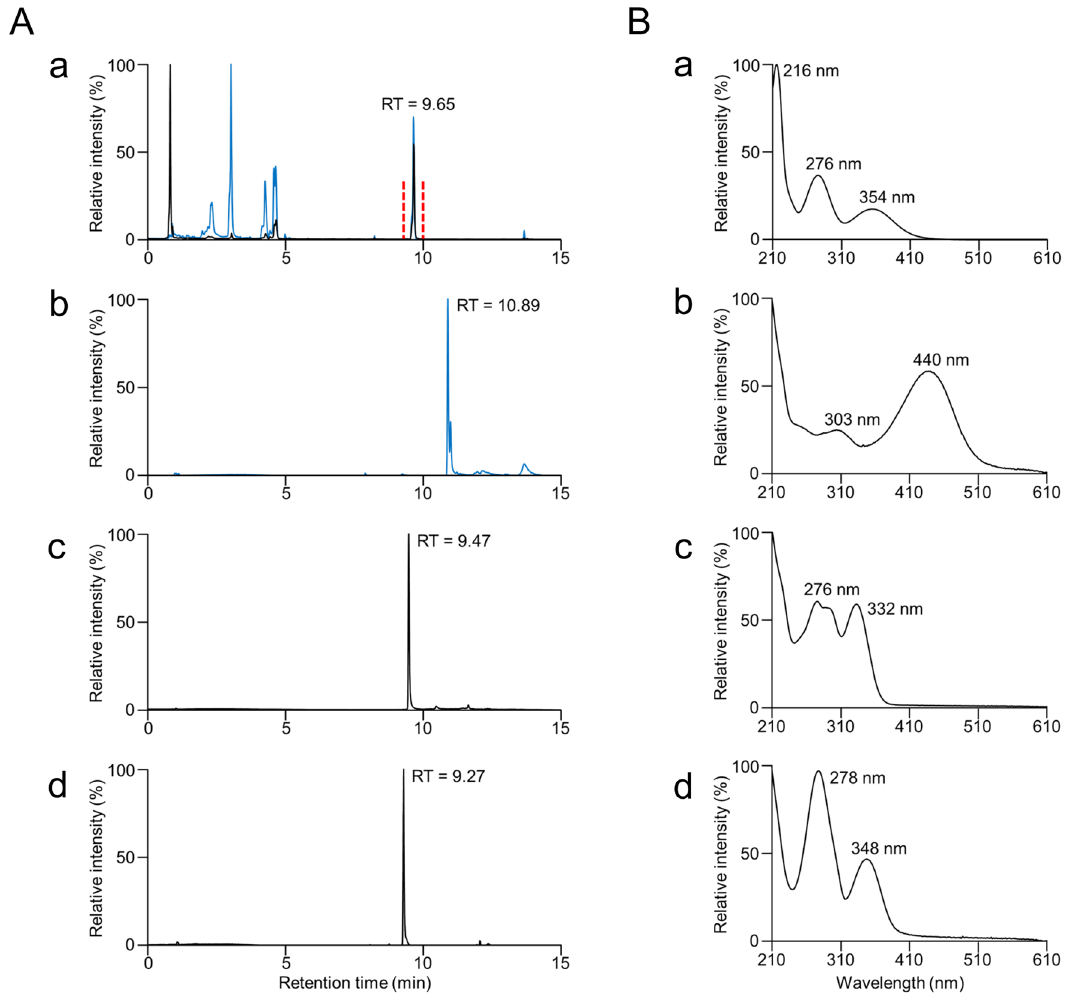
Figure 4. Comparison of the ethanolic extract of Polycirrus sp. ISK with CTZ, CTMD, and CTM. ( A ) UPLC analysis of (a) the extract, (b) authentic CTZ, (c) authentic CTMD, and (d) authentic CTM using a multiwavelength detector. The black solid line indicates detection at 333 nm, and the blue solid line indicates detection at 435 nm. The compound between the red vertical dashed lines was collected for MS/MS analysis. ( B ) Absorption spectra of the compound from the extract, CTZ, CTMD, and CTM obtained at retention times of (a) 9.65, (b) 10.89, (c) 9.47, and (d) 9.27 shown in ( A ). CTZ coelenterazine, CTMD coelenteramide, CTM coelenteramine. These chemical structures are shown in Supplementary Fig.